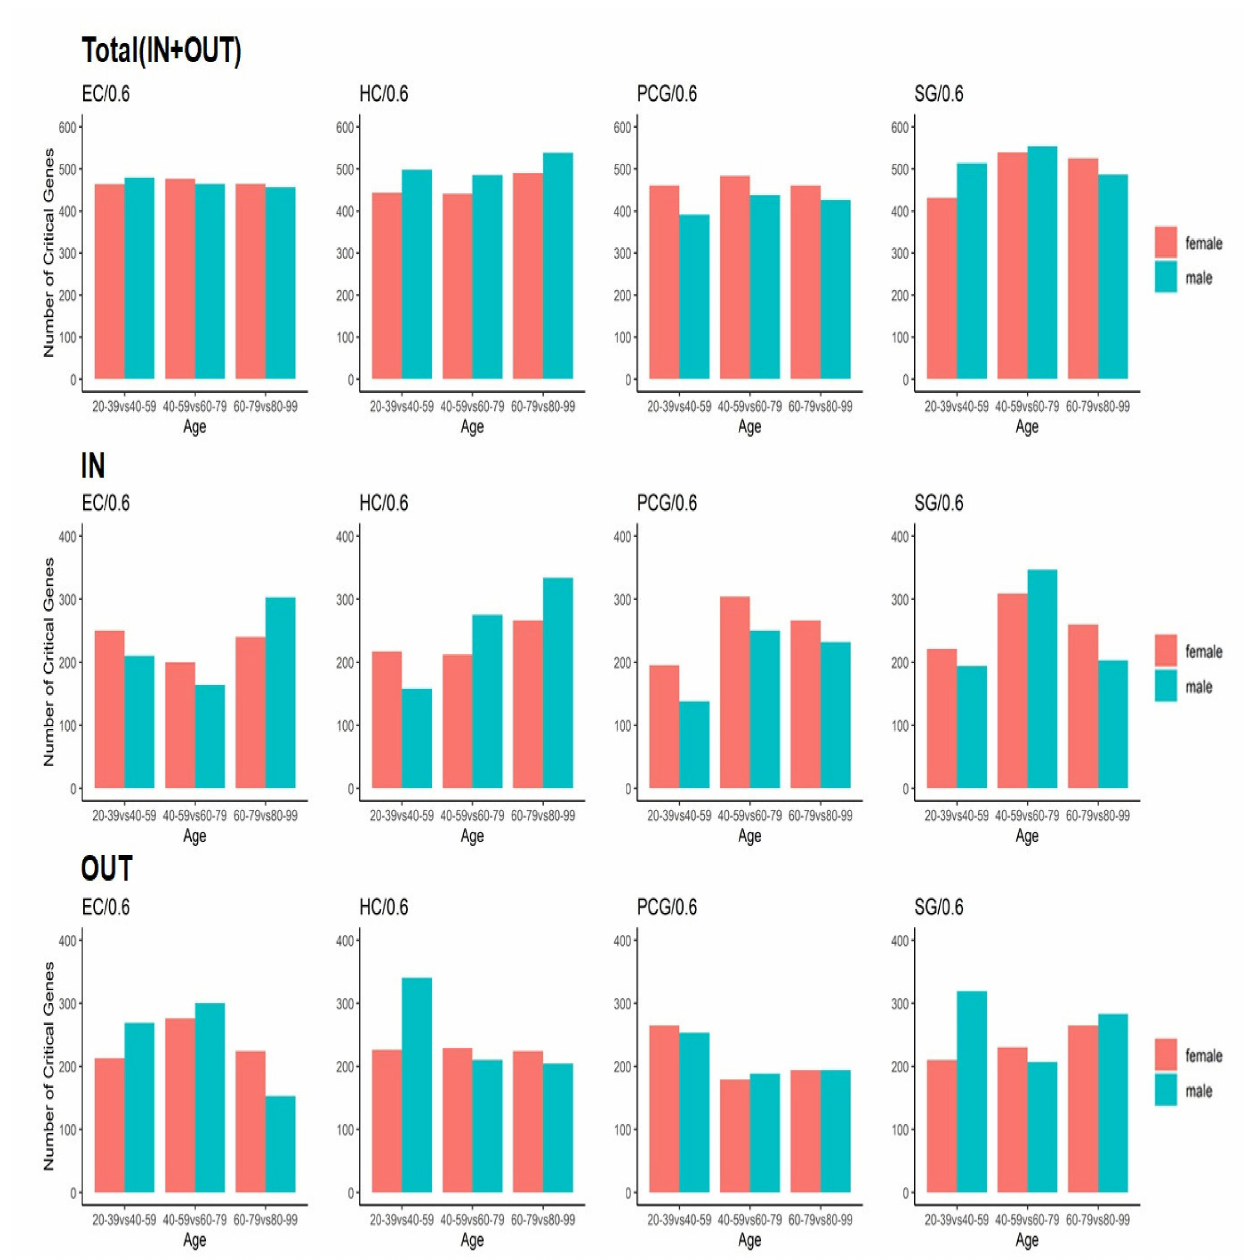
Figure 8. Distribution of the number of critical proteins that switched the control category between two consecutive age periods (horizontal axis) and computed for each threshold probability Θ = 0.6. The results for all four brain regions in females and males are shown. The total sum of the number of newly added critical proteins (IN) and the number of critical proteins that switched to different categories (OUT) is shown in the top